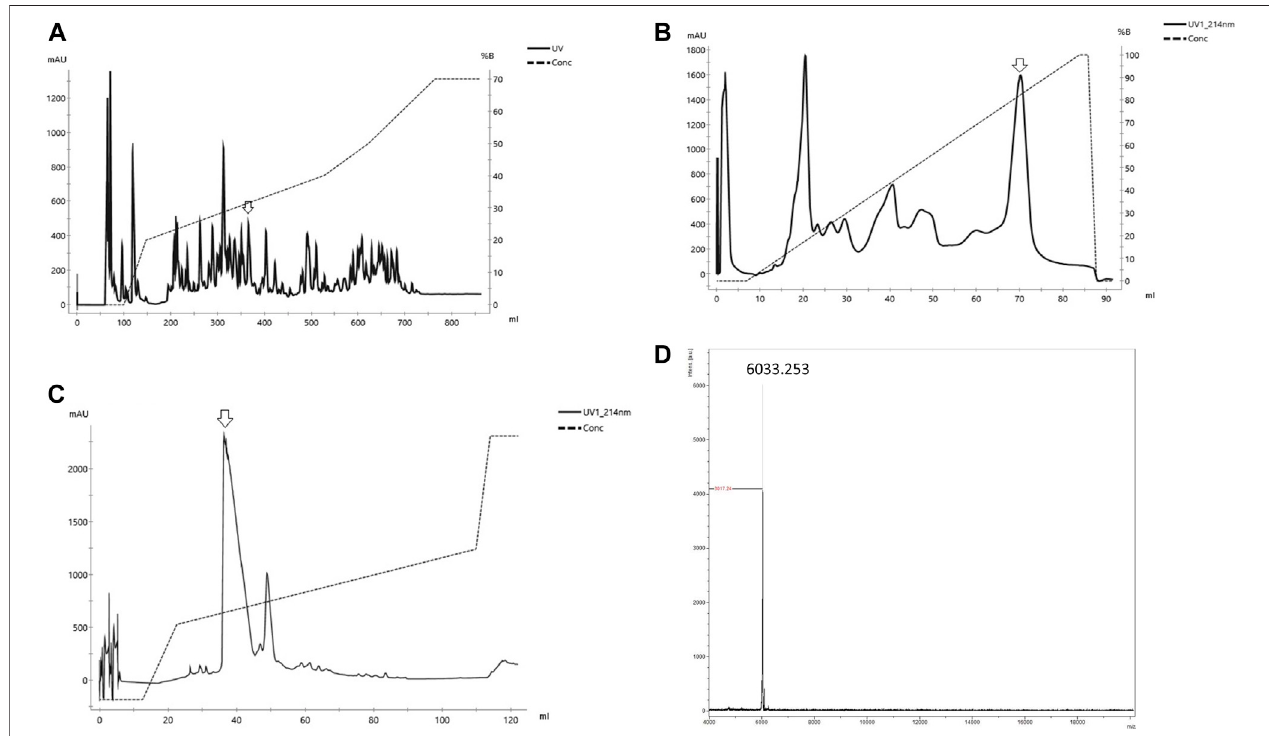
FIGURE 1 | Puri fi cation of Ph αβ from the venom of the spider P. nigriventer (A) Reverse phase of the crude venom of Phoneutria nigriventer spider in column C4 Vydac. (B) CationexchangeHPLCofthefractionPh αβ from (A) onHitrapSpHpcolumn (C) ReversephasedesaltingofPh αβ from (B) inacolumnC18smallpore(arrow indicates the peak used in each step) (D) Mass spectra of the Ph αβ MS obtained on MALDI/TOF in positive/linear mode (laser frequency 100%, mass range 2 – 20,000 ( m/